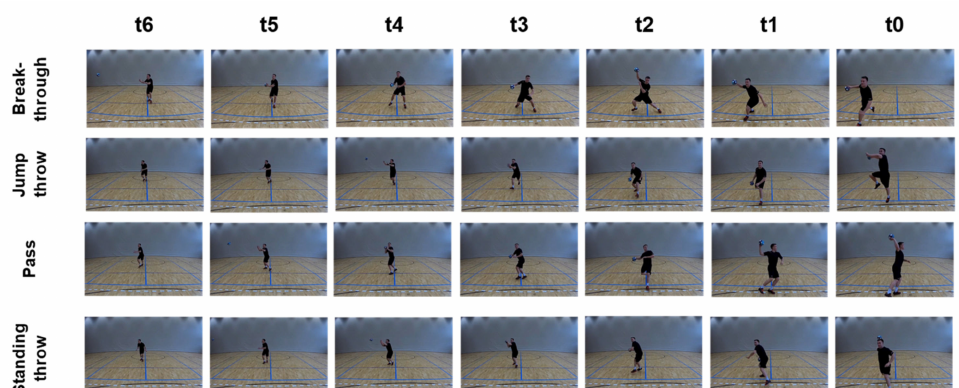
Figure 2. Screenshots of occlusion time points of the 4 right-hand baseline video stimuli. Break- through began with a pass from the left back player to the center back player in a parallel standing position, who made a fluent deceptive move and two steps to the right, followed by a throw after a single-leg jump. The jump throw was executed after a pass from the left side, catching the ball and a two-step run-up. The standing throw was executed after a pass from the left side, catching the ball and a three-step run-up. The pass was executed after a pass from the left side, catching the ball, two steps and a pass to the right